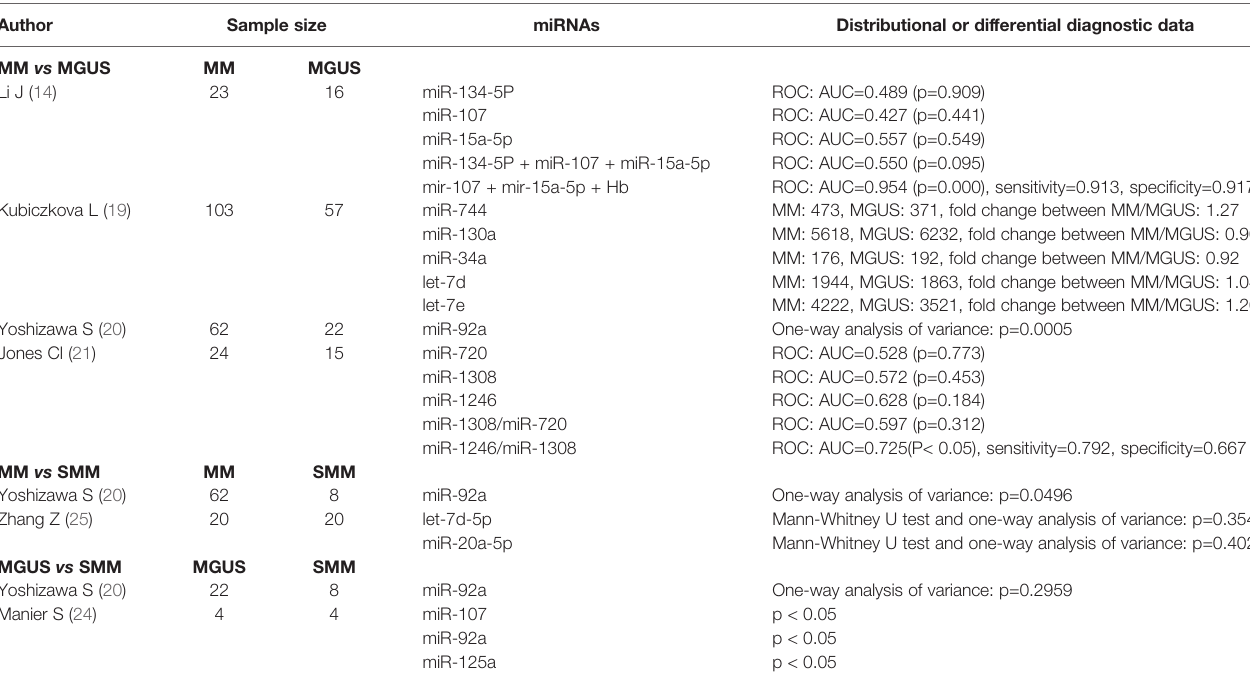
TABLE 5 | Circulating miRNAs in MM, MGUS, and